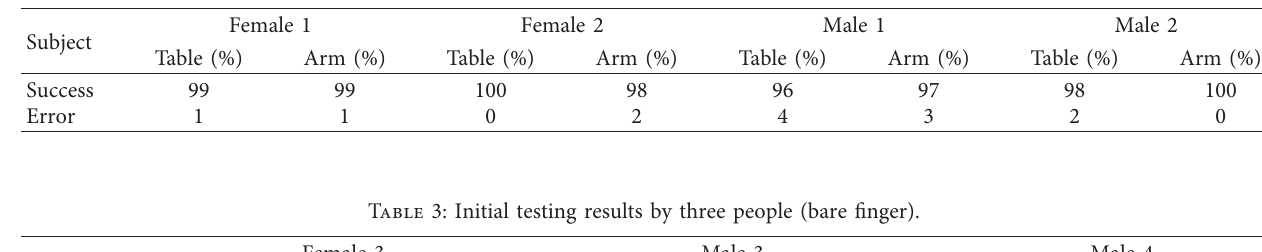
Table 2: Initial testing results by four people (input finger).